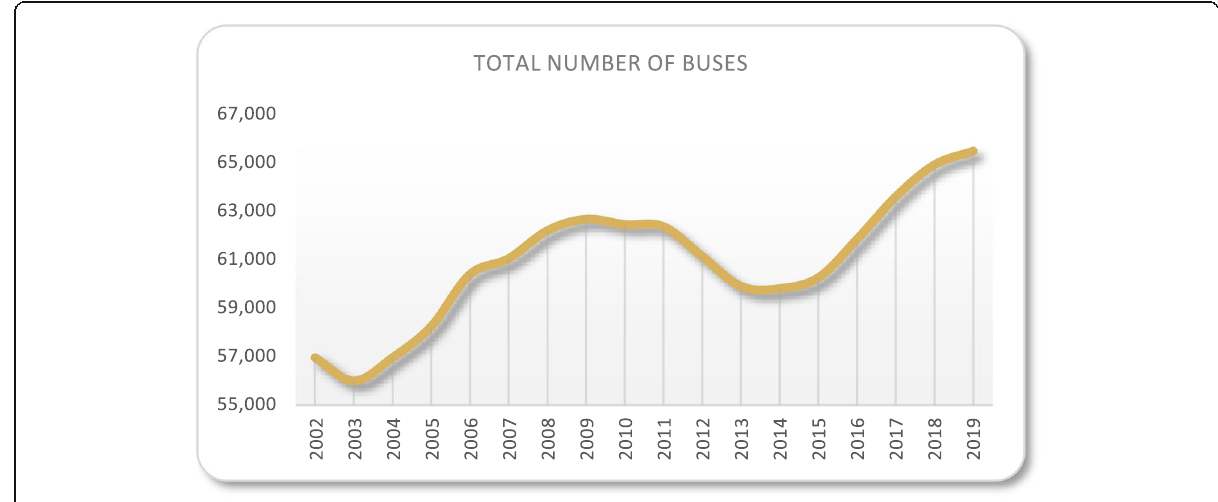
Fig. 5 The total number of buses in Spain (2019 data)